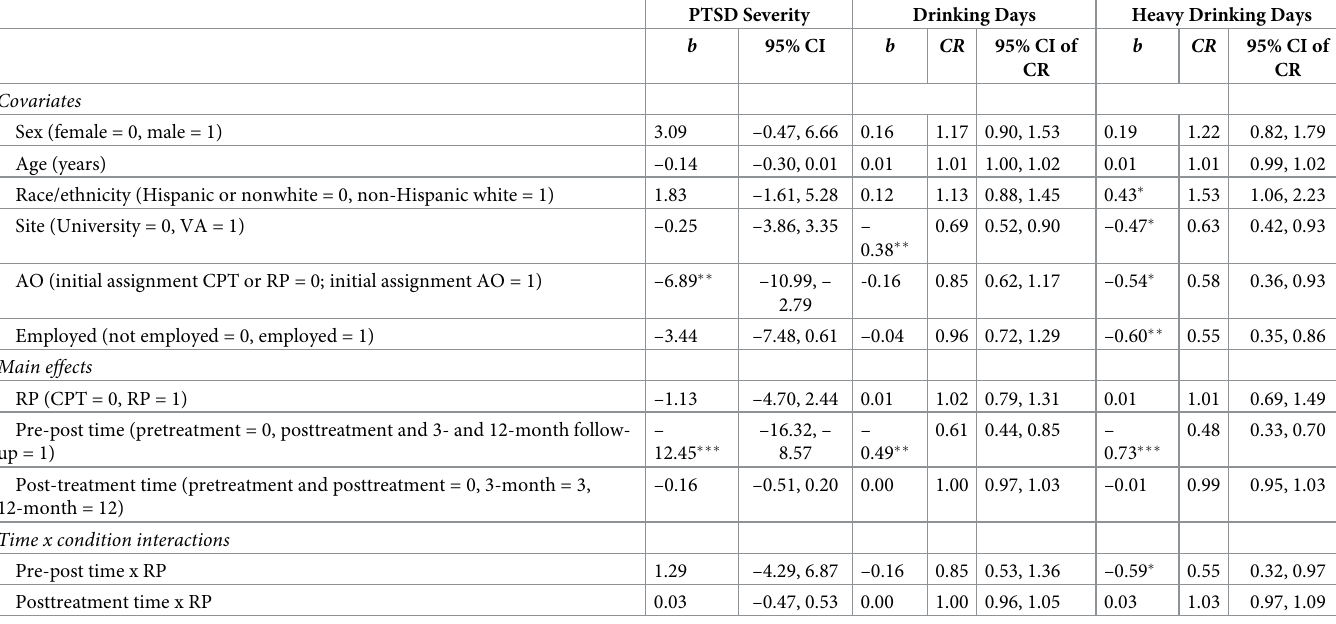
Table 3. Model estimates for final treatment